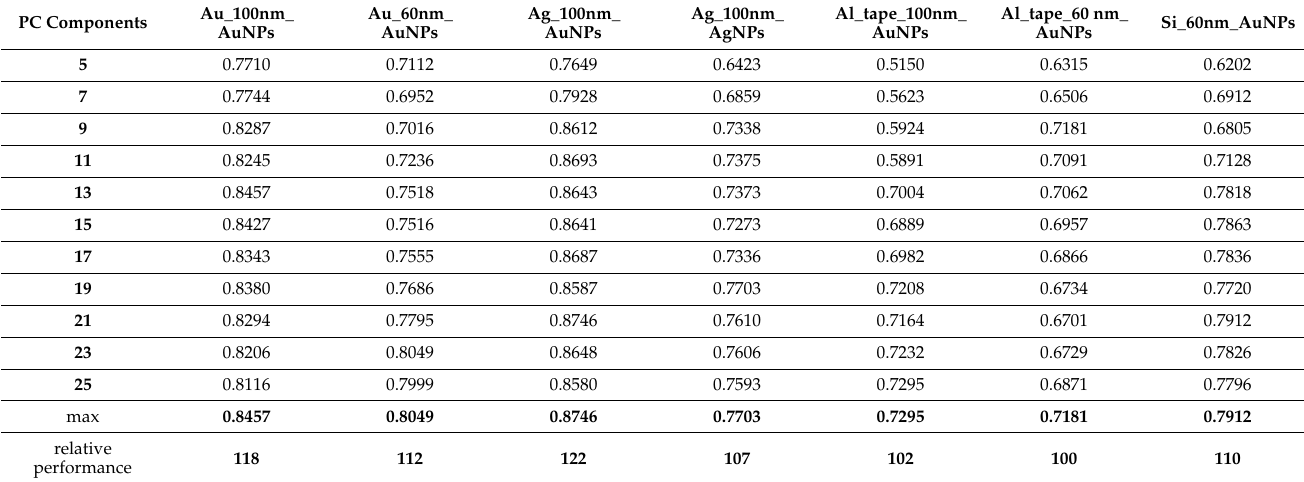
Table 2. Average of AUC values for each experimental set compared to PC components.